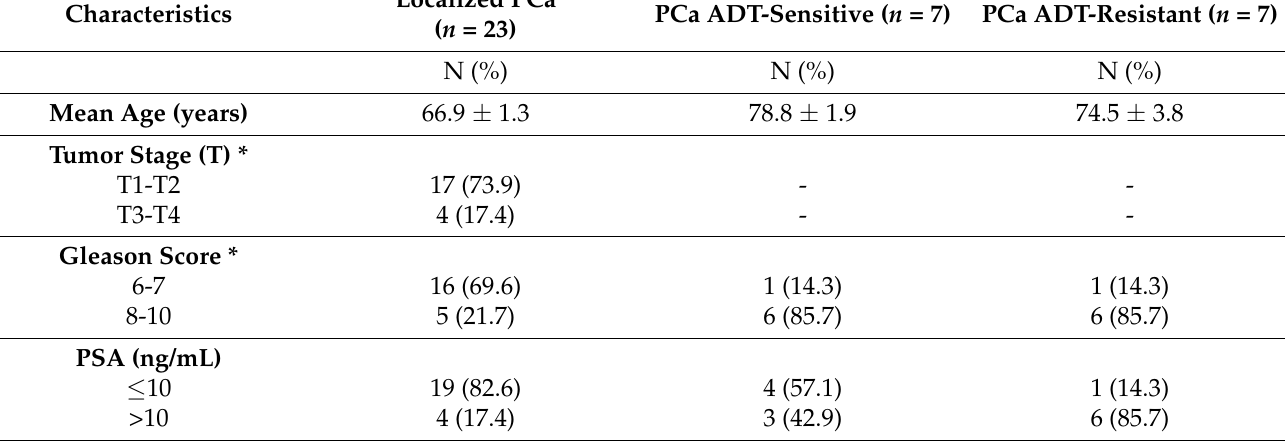
Table 1. Basal characteristics of patients with prostate